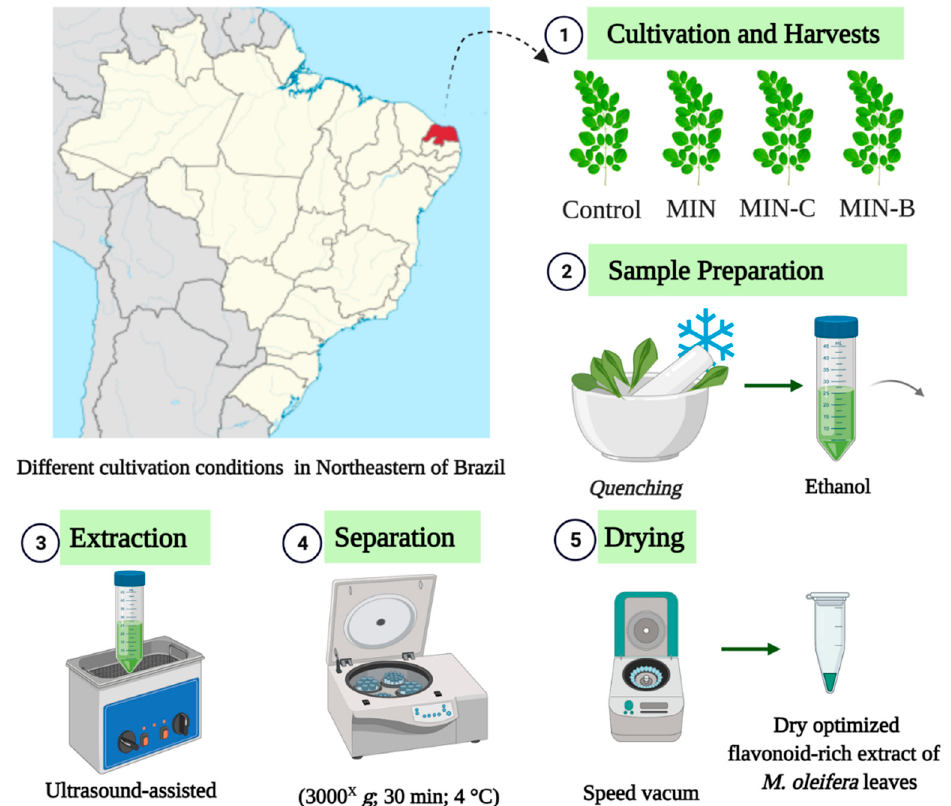
Figure 1. Graphical presentation of the protocol to obtain an optimized process of flavonoid-rich ex- traction from Moringa oleifera leaves employing ultrasound-assisted extraction (UAE). ( 1 ) Cultivation conditions: Control (untreated local soil); MIN (100% mineral cultivation); MIN-C (50% min- eral soil fertilizer with 50% composting); and MIN-B (50% mineral cultivation with 50% Biochar (3.0 t/ha); ( 2 ) Sample preparation with metabolic quenching and ethanol as extraction solvent; ( 3 ) Ultrasound-assisted extraction; ( 4 ) Supernatant separation by centrifuge; ( 5 ) Sample dryer and the final optimized flavonoid-rich extract of M. oleifera